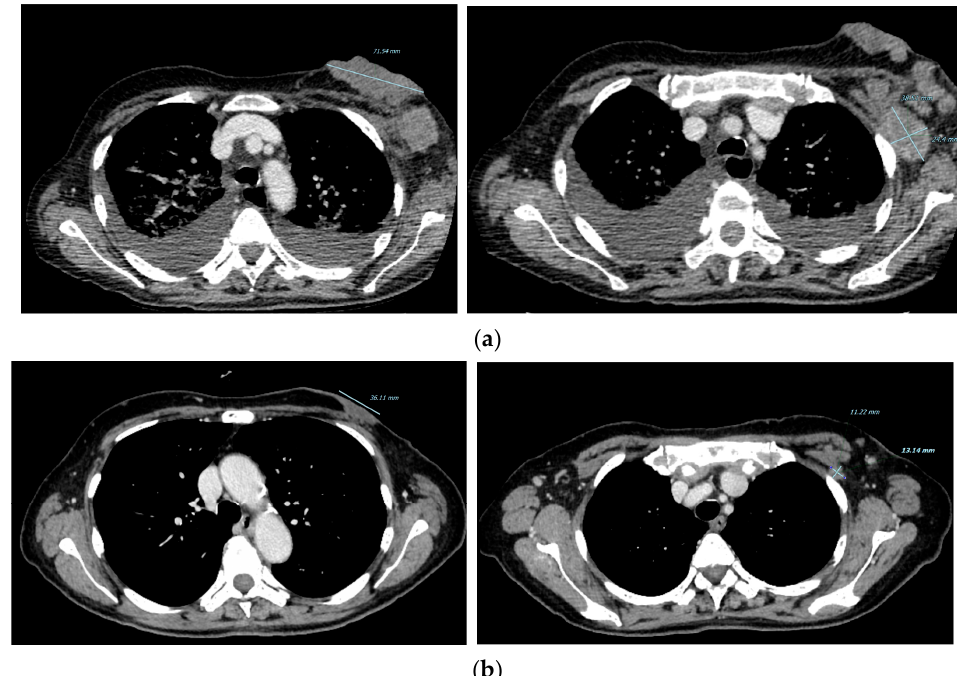
Figure 2. Baseline CT scan evaluation and subsequent time point: ( a ) CT scan March 2021, basal evaluation: left breast primitive lesion and left axilla lymphadenopathy; ( b ) CT scan November 2021: size reduction of left breast primitive lesion and left axilla lymphadenopathy.